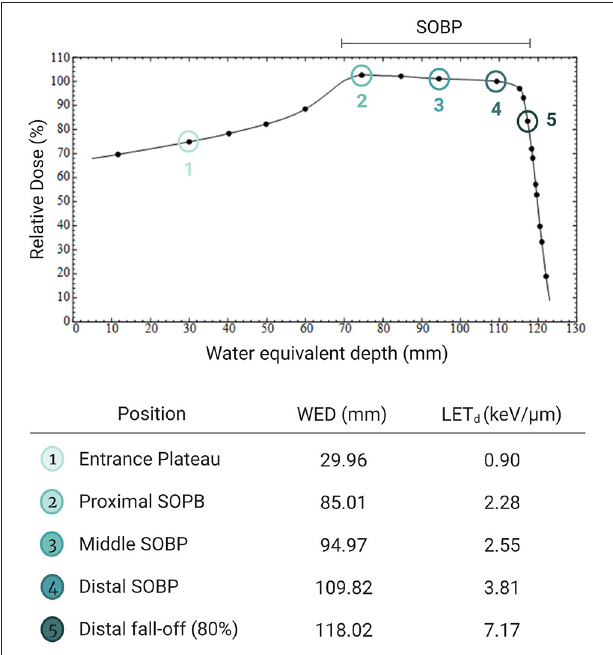
FIGURE 1 | Illustration of the five different irradiation positions with a modulated 200 MeV proton beam with a 50mm spread-out Bragg peak (SOBP) and a range of 120mm; with the corresponding Water Equivalent Depth (WED) in the Perspex phantom and the increasing LET d values. Created with